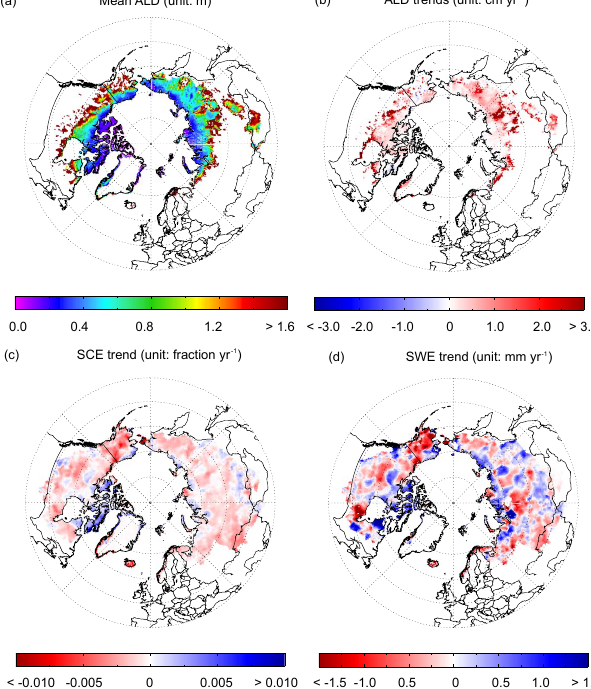
Figure 4. Model-simulated spatial pattern of active layer depth (ALD, a ) and estimated trends in ALD (b) , snow cover extent (SCE, c ) and snow water equivalent (SWE, d ) over the pan-Arctic basin and Alaska domain from 1982 to 2010. Areas in white are non- permafrost areas (a, b) or outside of the modeling